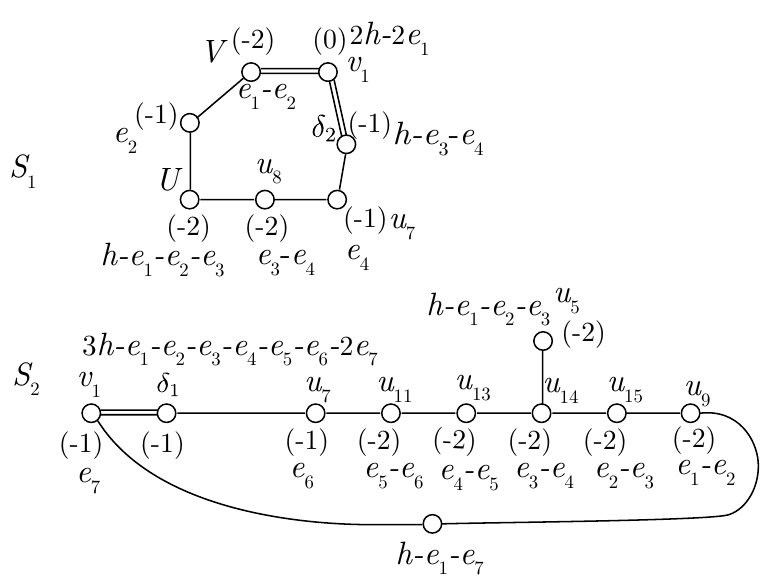
Figure 40. One concrete resolution of the ( E 8 ; SU(2)) model that corresponds to a marginal theory in 5d. This geometry is obtained by a sequence of (cid:13)ops from the tensor branch resolution of the 6d rank two E-string. One of these (cid:13)ops change the genus of the gluing curve S 1 \ S 2 = f (cid:14) 1 g\f (cid:14) 2 g from 1 to 0. Each depicted node is rational curve generating the Mori cone of each the corresponding